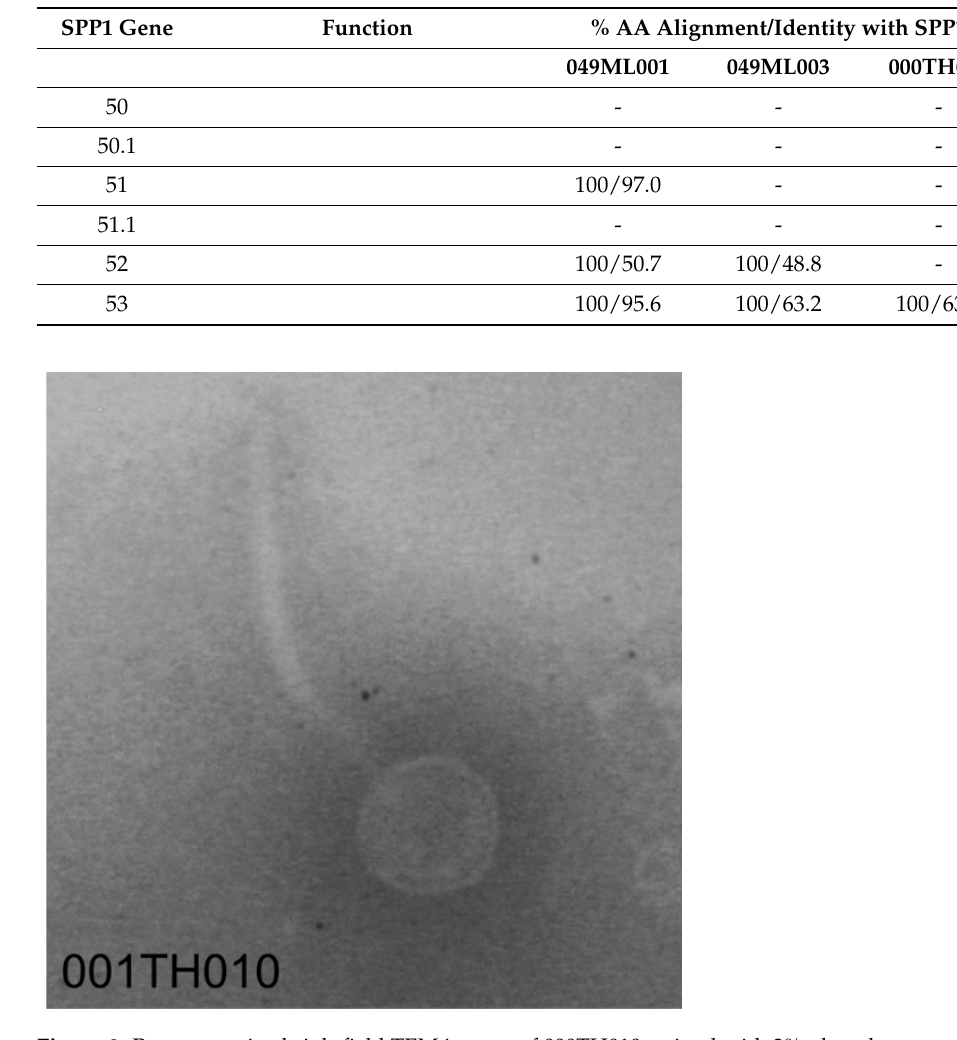
Figure 3. Representative brightfield TEM images of 000TH010 stained with 2% phosphotungstic acid. Images were taken at 50,000 × magnification using a Zeiss EM 109. Table 2. Comparison of our phages to the revisited annotation of phage SPP1 from [25]. SPP1 gene